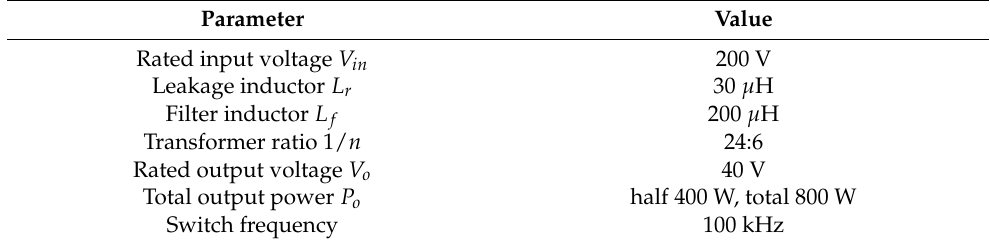
Table 2. Values of PSFB-related